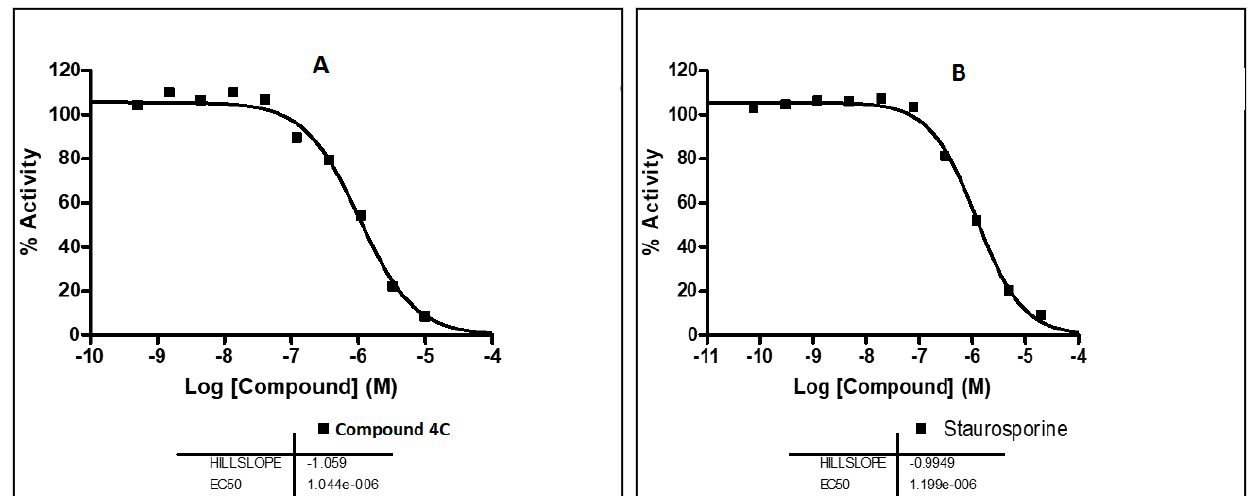
Figure 5. IC 50 values of compound 4c ( A ) and staurosporine ( B ) over EphB3 kinase.